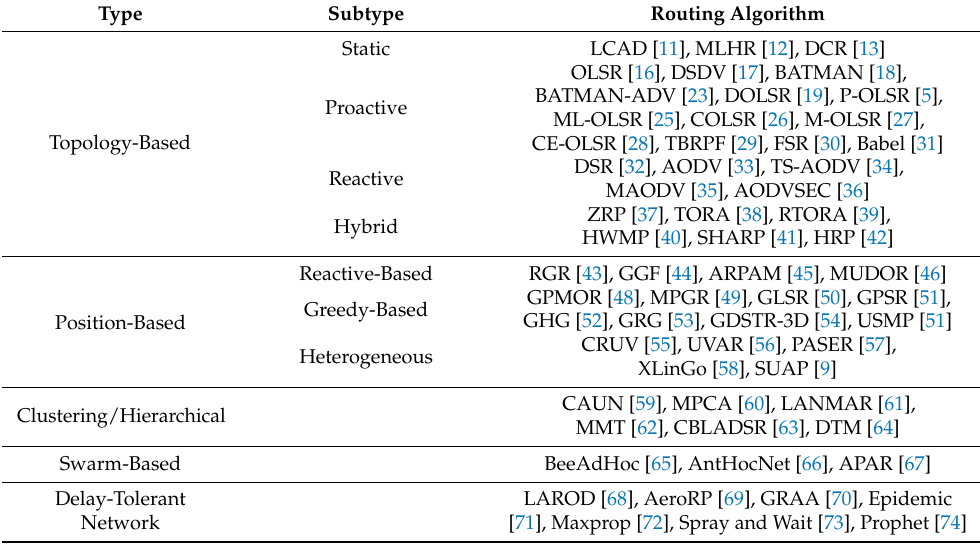
Table 2. A summary of routing algorithms and their classes and